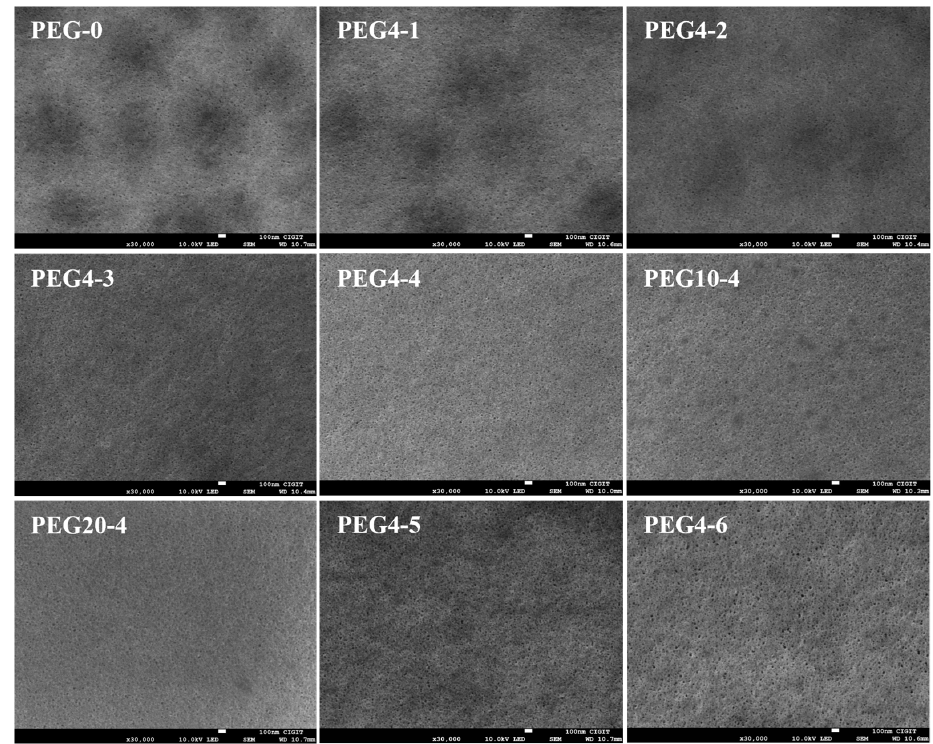
Figure 2. SEM images for the top surfaces of PSU and PSU/PEG substrates.